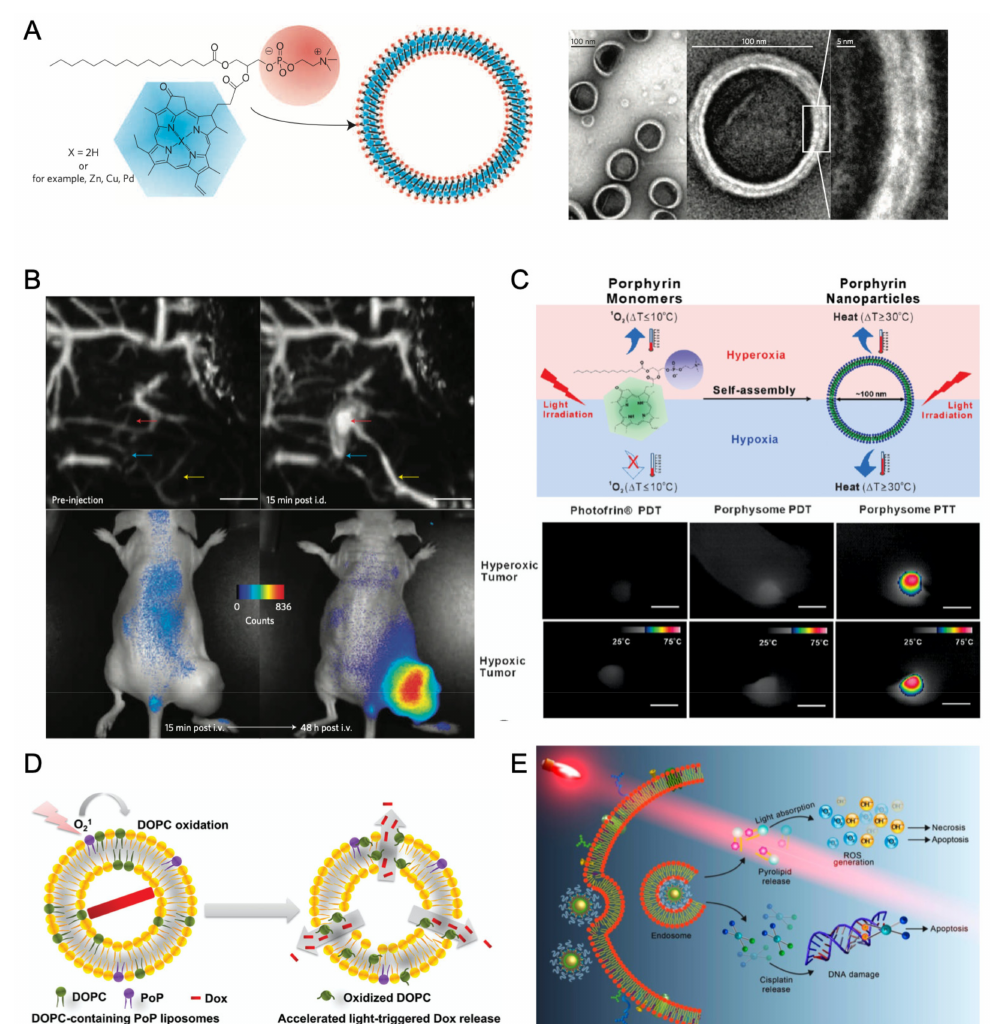
Figure 8. ( A ) Schematic representation of a pyropheophorbide–lipid porphysome highlighting the phospholipid headgroup (red) and porphyrin (blue) in the PoP subunit and assembled nanovesicle (left), and electron micrographs of negatively stained porphysomes (right) [136]. Copyright © 2011, Nature Publishing Group. ( B ) Dual modality for photoacoustic con- trast and activated fluorescence: Lymphatic mapping in rats using photoacoustic tomography before and after intradermal injection of porphysomes (top left and right panels, respectively); fluorescence activation after intravenous injection of porphysomes in a KB xenograft-bearing mouse for 15 min and 48h time delays (bottom left and right panels, respectively). Adapted with permission from [136]. Copyright © 2011, Nature Publishing Group. ( C ) Scheme of nanostructure-driven conversion from the PDT singlet oxygen generating mechanism of porphyrin to a completely thermal mechanism based on fluorescence self-quenching, which can be employed for PTT enhancement (top). Temperature increase upon laser irradia- tion captured by a thermal camera in hyperoxic and hypoxic tumors subjected to various irradiations with: Photofrin PDT, porphysome PDT, and porphysome PTT (scale bar: 8 mm) [137]. Copyright 2013 American Chemical Society. ( D ) Scheme of light-triggered Dox releasing from PoP liposomes, which is induced by DOPC oxidation due to singlet oxygen generation upon irradiation [138]. © 2016 WILEY-VCH Verlag GmbH & Co. KGaA, Weinheim. ( E ) Scheme showing endocytosis of NCP@pyrolipid and subsequent apoptosis/necrosis by combined chemotherapy and PDT. Adapted with permission from [139]. Copyright 2015 American Chemical